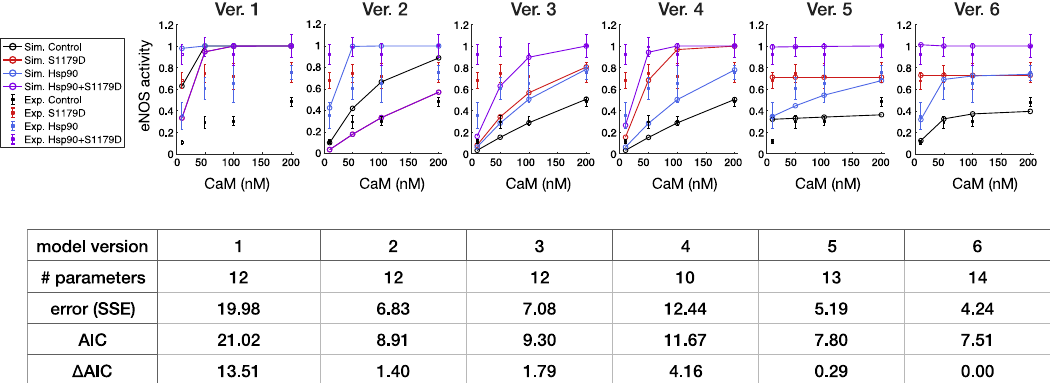
Figure A1. eNOS module fitting and AIC test. Each version of the eNOS model was trained using the lsqnonlin algorithm to match with four sets of experimental data of eNOS activity. The AIC score was computed taking into account the total number of parameters in fitting and the sum of squared error (SSE) for each model version. The difference of each model AIC score compared to the final version, ∆ AIC, was computed. Hsp90, Heat Shock Protein 90; eNOS, Endothelial Nitric Oxide Synthase; CaM, Calmodulin; AIC, Akaike Information Criterion.